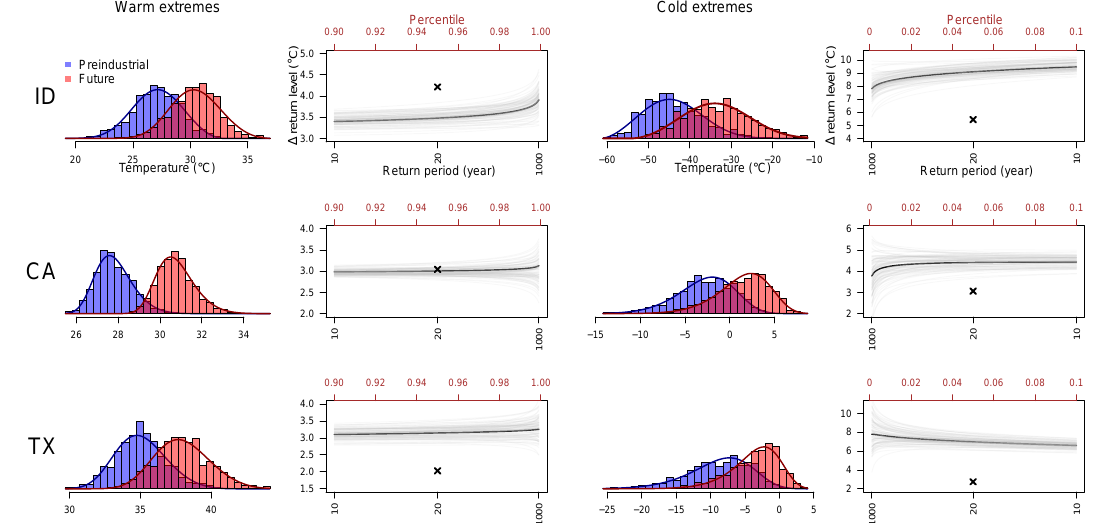
Figure 6. Illustration of the changes in return levels and their relationship with the changes in seasonal means. The histograms are for the 1000 annual maxima (warm extremes) and minima (cold extremes) for the pre-industrial (289ppm, blue) and future (700ppm, red). Smooth curves are corresponding estimated GEV distributions. Return level plots show changes in estimated return levels (dark curve) and uncertainty from the bootstrap procedure (lighter curves). The corresponding changes in seasonal means are marked with a cross (change in mean summertime daily maximum for warm extremes and mean wintertime daily minimum for cold